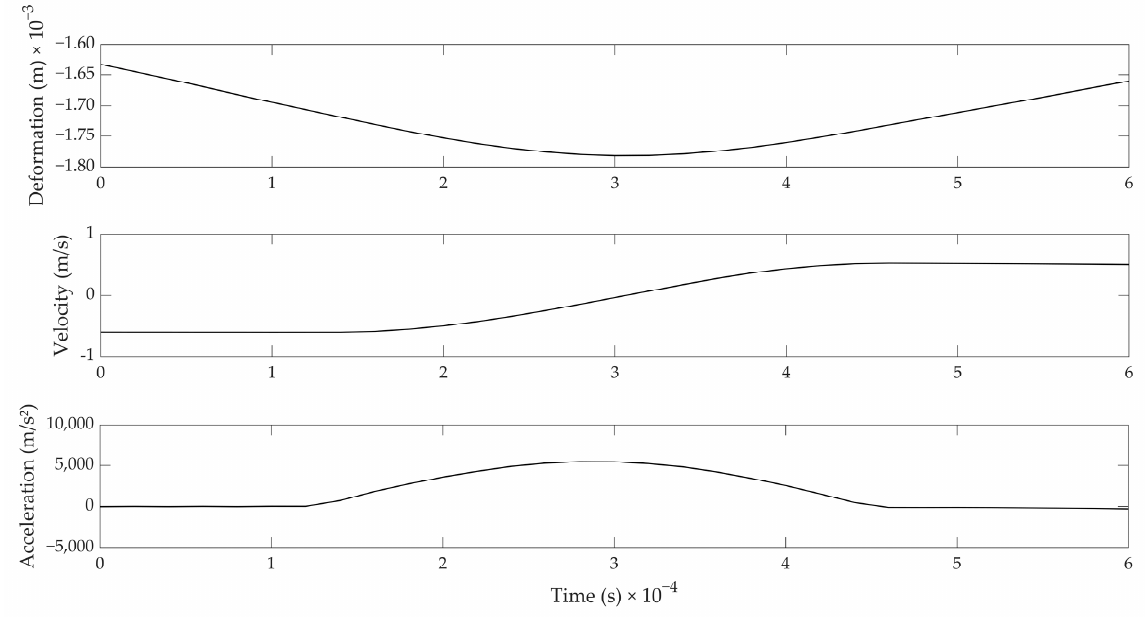
Figure 2. Impact on an intact egg by a small steel ball: Velocity data retrieved from sampling the laser vibrometer at 50 kHz ( middle ); Deformation (m) signal obtained through integration ( top ); and Acceleration signal (m/s²) obtained through derivation ( bottom ).